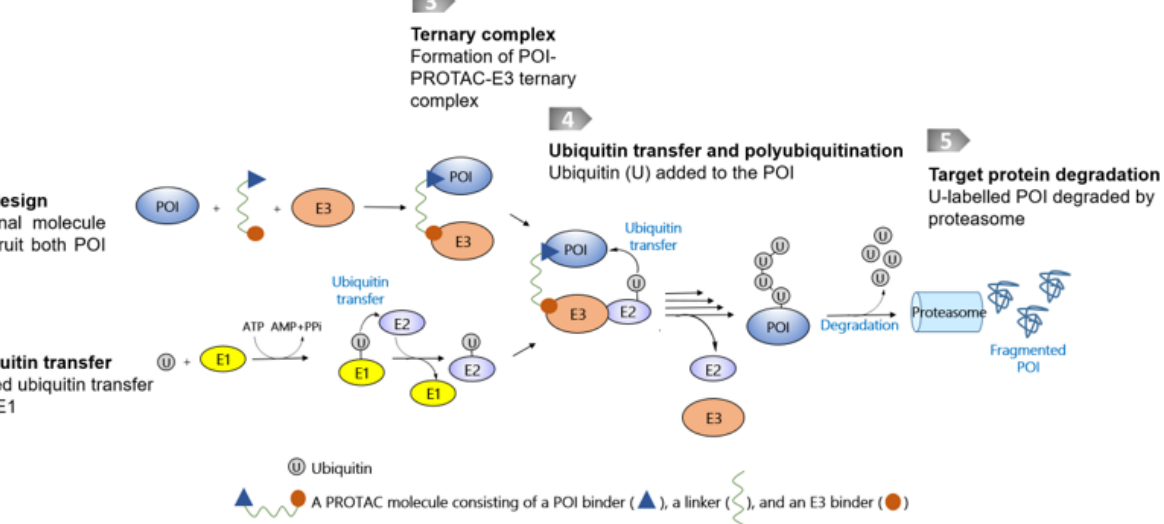
Figure 1. Schematic diagram of a PROTAC molecule and its degradation pathway. The degradation pathway is reliant on E1, E2, and E3 ligases and proteasome. The E3s are recruited to POI by PROTACs, thereby inducing ubiquitylation and proteasomal degradation.